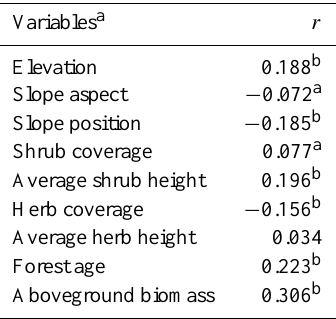
Table 2. Spearman correlation coefficients between forest litter car- bon density and other